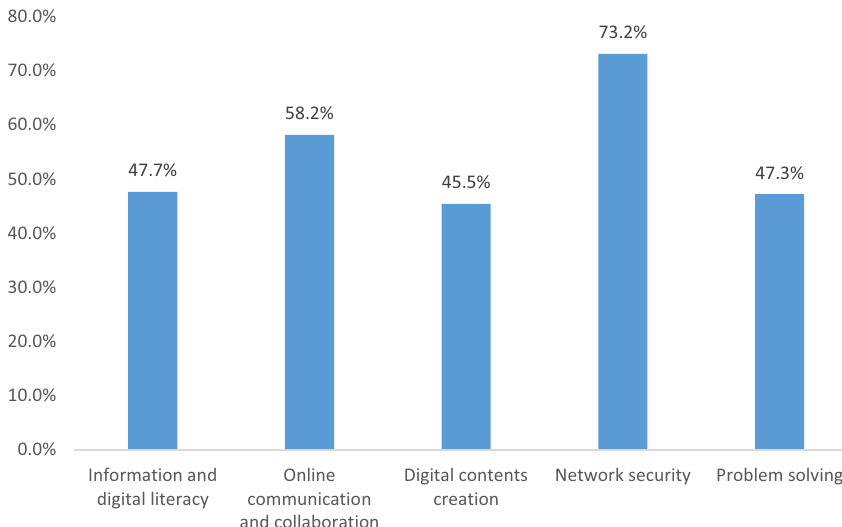
Fig. 3 Level of achievement in the areas of digital